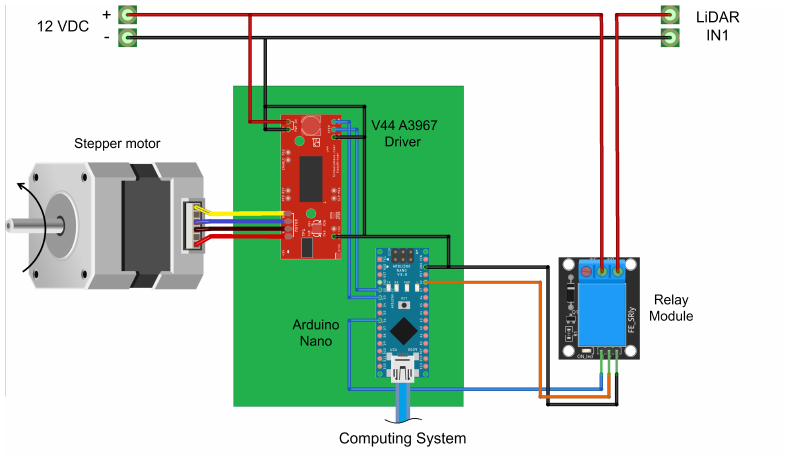
Figure 3. Schematic diagram of the connections for the electronic